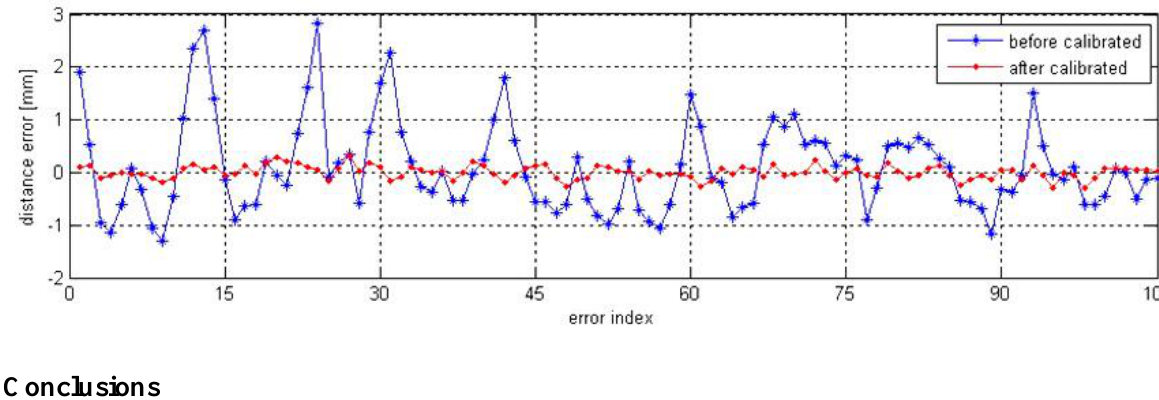
Figure 10. Distance error before calibration and after